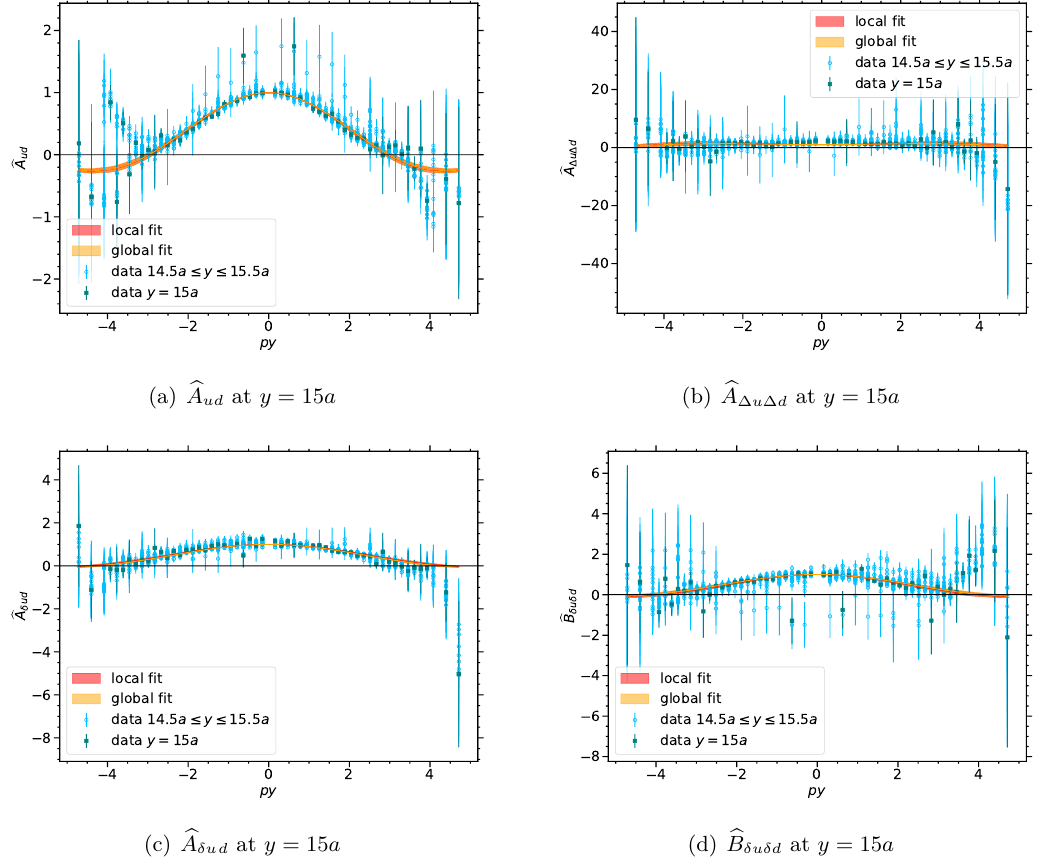
Figure 26 . Data and fits of the py dependence of normalised invariant functions. Dark points show data at y = 15 a . Light points show data in a y range of a/ 2 around 15 a , which are included in the local fits. The plot for b A δuδd (not shown) is qualitatively similar to the one for b B δuδd .